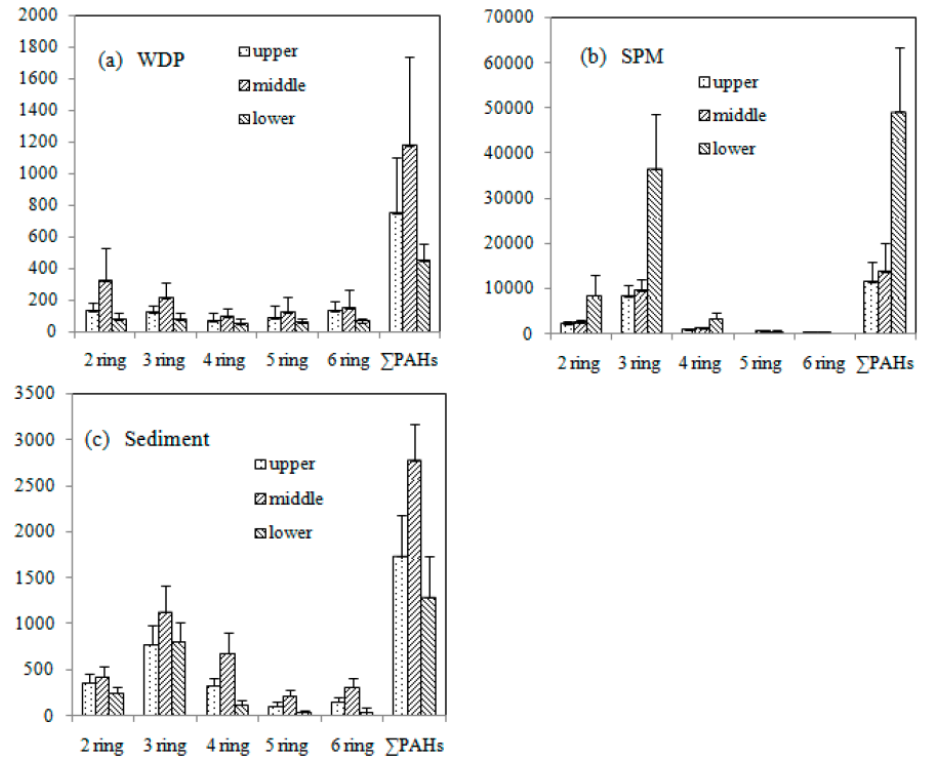
Figure 3. The concentration of PAHs in upper, middle and lower reaches in Weihe